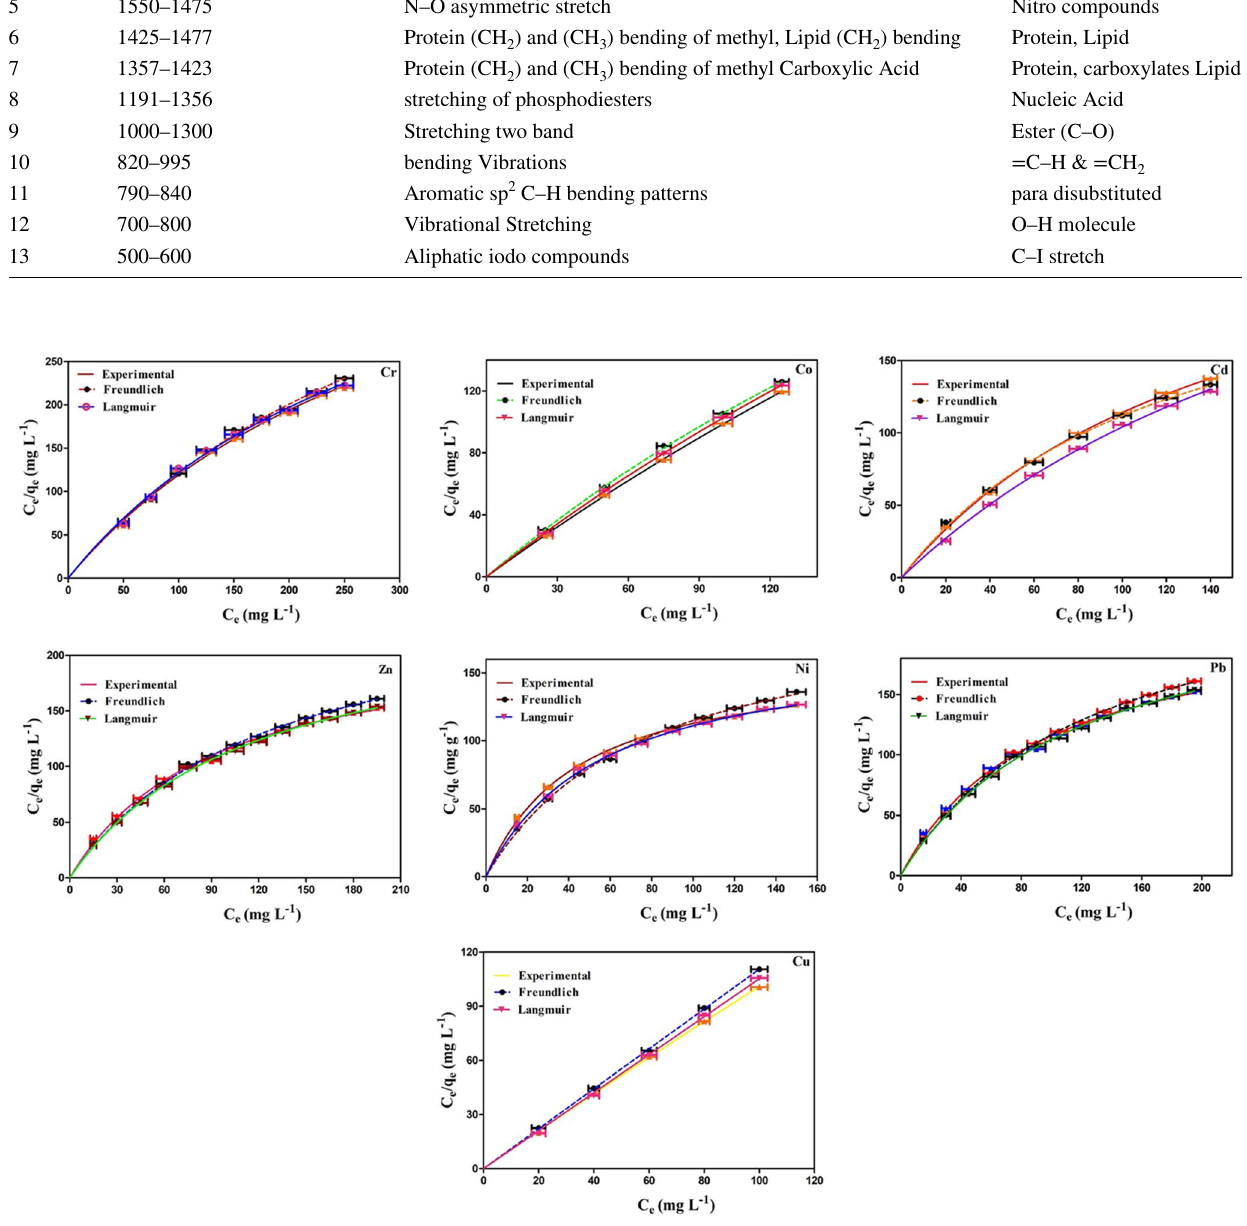
Fig. 1 Biosorption of heavy metals for Freundich and Langumuir kinetics isotherm model